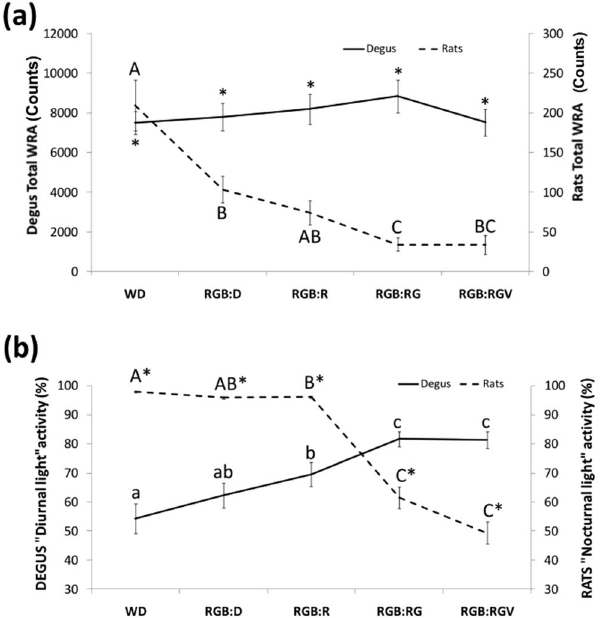
Figure 4. Total and day/night-time percentage of activity. ( a ) Total wheel running activity levels throughout the day (24 h) for degus (continuous line, n = 27) and rats (dashed line, n = 12). ( b ) Percentage of activity during the typical active period of degus (daytime) and rats (night-time). For more details, see the Materials and Methods section). Data are shown as the mean ± SEM. Different letters indicate statistically significant differences (repeated measures ANOVA, Bonferroni post-hoc, p < 0.05) between light conditions and * indicates statistically significant differences between degus and rats (Student’s t-test, p <